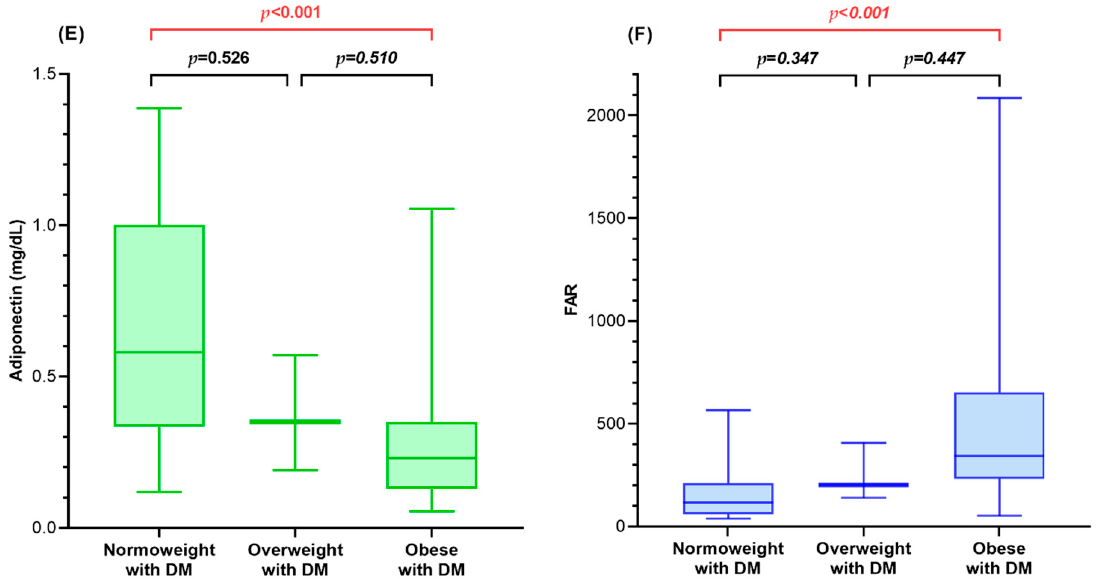
Figure 1. Controls ( A – C ) and diabetic children ( D – F ) were subcategorized into three groups according to body mass index status. Box plots were drawn to compare fetuin-A, adiponectin, and the fetuin-A-to-adiponectin ratio. Boxes represent the interquartile range, whereas lines inside the boxes represent the median value. Whiskers represent the lowest and highest observations.